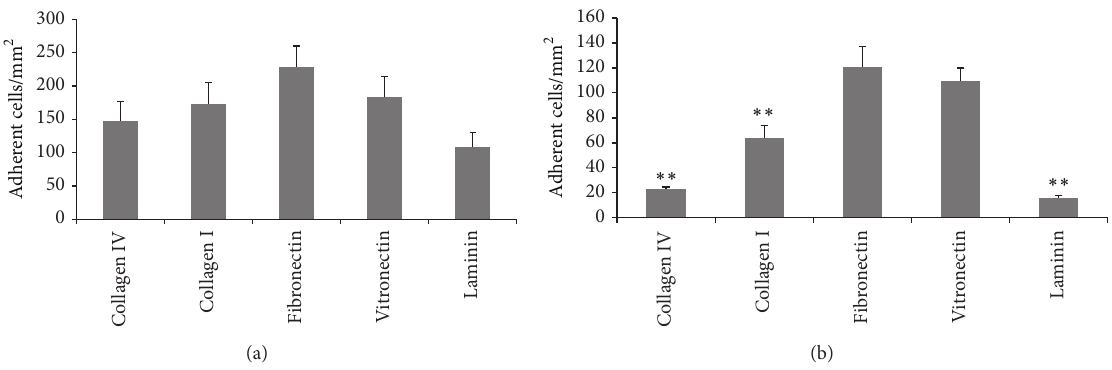
Figure 5: LO-EPC adhesion to various extracellular matrix proteins under static and flow conditions. 2 × 10 4 of LO-EPC were plated to Ibidi 𝜇 -Slide VI 0.4 Luer slides for 45 min to study the static adhesion of LO-EPC to various ECM (a). Dynamic adhesion of LO-EPC to various extracellular matrix proteins under 0.7dyn/cm 2 shear stress (b). 4 × 10 5 EPC were perfused into Ibidi 𝜇 -Slide VI 0.4 Luer slides coated with 100 𝜇 g/mL collagen IV, collagen I, fibronectin, vitronectin, and laminin, respectively. The data was represented as mean ± SE of three experiments. ∗∗ 𝑝 < 0.01 compared to